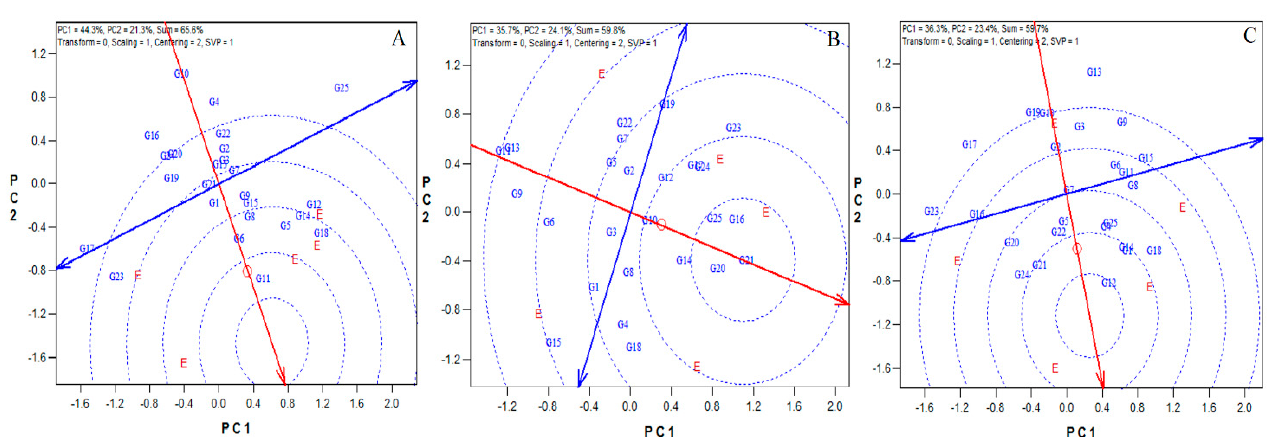
Figure 5. Ranking biplot for comparison of the genotypes with the ideal genotype. ( A ): First year, ( B ): Second year, ( C ): Average of two years. G1:, G2:, G3:, G4:, G5:, G6:, G7:, G8:, G9:, G10:, G11:, G12:, G13:, G14:, G15:, G16:, G17:, G18:, G19:, G20:, G21:, G22:, G23:, G24:, G25:(DAM: DAMA- VAND, VAR: VARAMIN, KRJ: KARAJ, ESF: ESFAHAN, QAZ: QAZVIN).